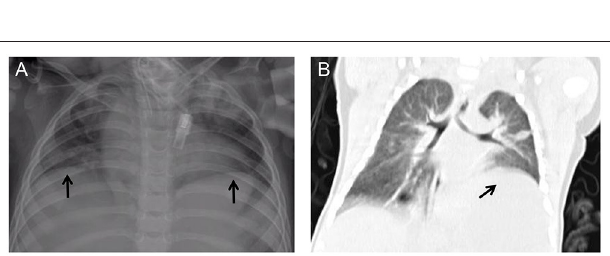
FIGURE 3 | Post-operative image of fiberoptic bronchoscopy stent implantation (A) and chest X-ray [ (B) , arrow].